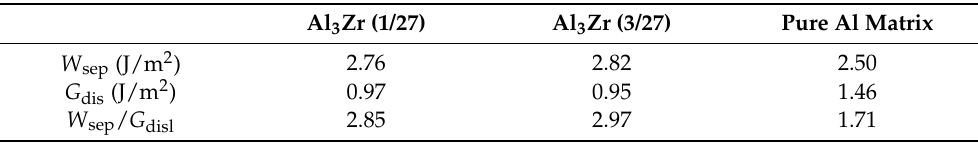
Table 5. The work of dislocation emission G disl , the work of separation W sep , the unstable stacking fault energy γ usf and the ratio ( W sep / G disl